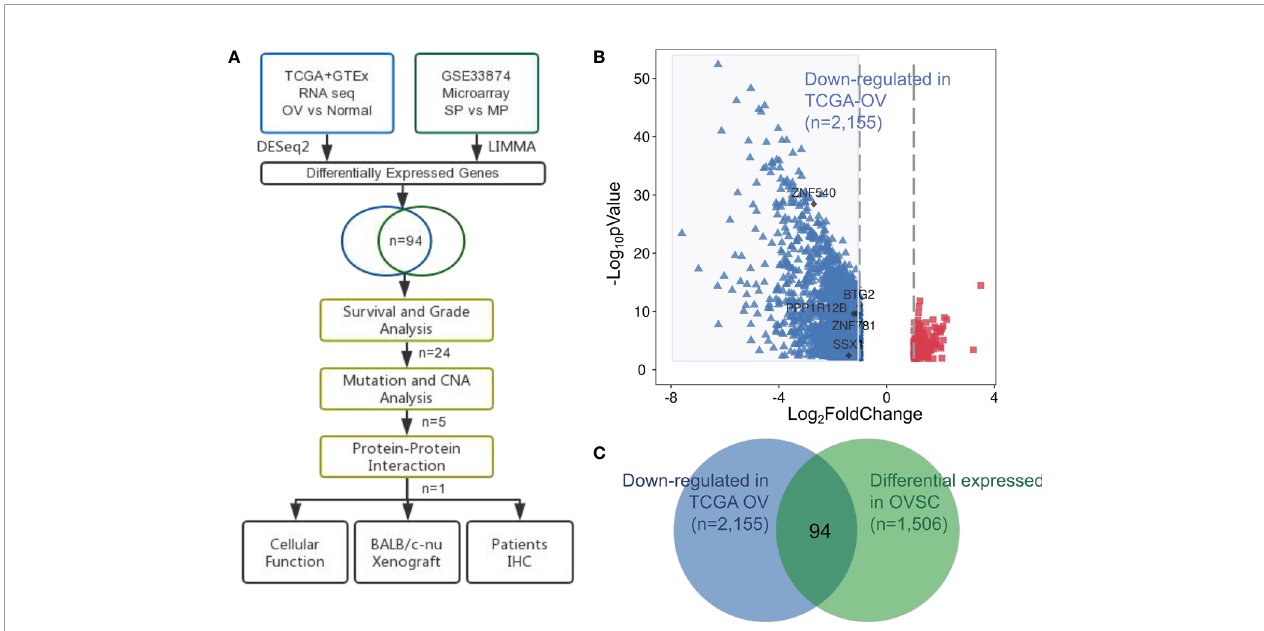
FIGURE 1 | Identi fi cation of aberrantly expressed tumor suppressors in ovarian cancer. (A) Flow chart of methodologies applied in the current study. (B) Volcano plot of fold changes in the expression of the DEGs in ovarian cancer patients. Red rectangle dots, signi fi cantly upregulated genes, blue triangle dots, signi fi cantly downregulated genes and black dots, hub genes. (C) Venn diagram of the 94 signi fi cantly co-expressed genes compared with down-regulated in ovarian cancer and differential expressed in